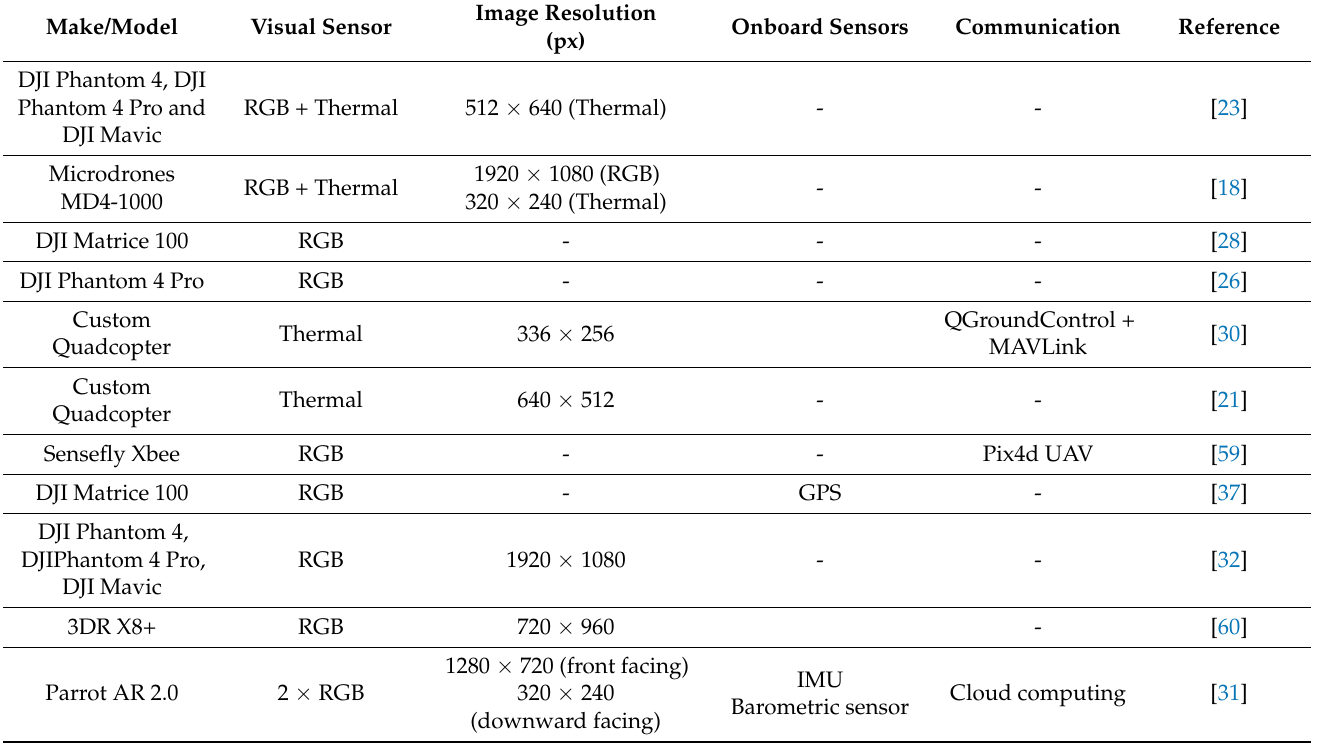
Table 1. Drone architecture in the literature utilized for crowd monitoring and analysis